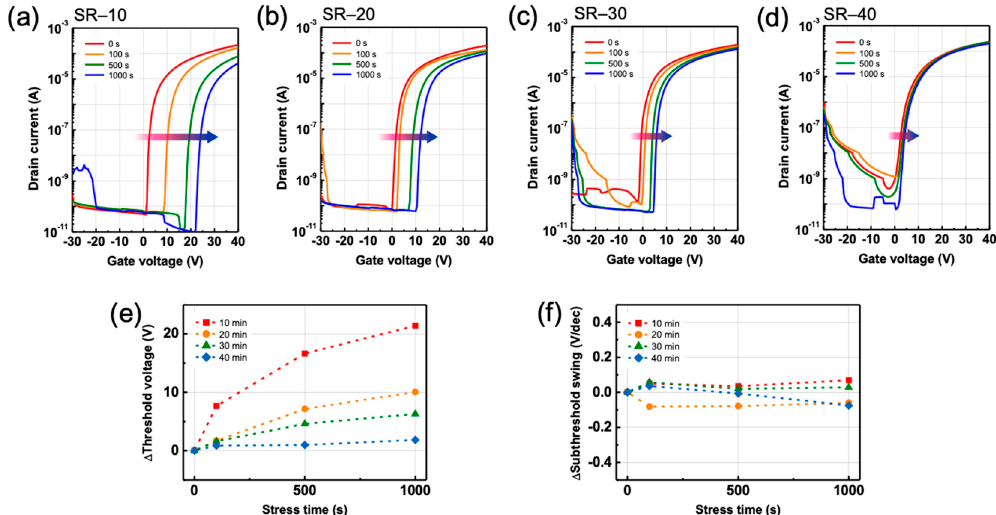
Figure 6. Transfer characteristics as a function of a positive-bias stress time for ZTO TFT specimens: ( a ) SR-10, ( b ) SR-20, ( c ) SR-30, and ( d ) SR-40. ( e ) Threshold voltage and ( f ) subthreshold swing shift of ZTO TFTs for a positive-bias stress.